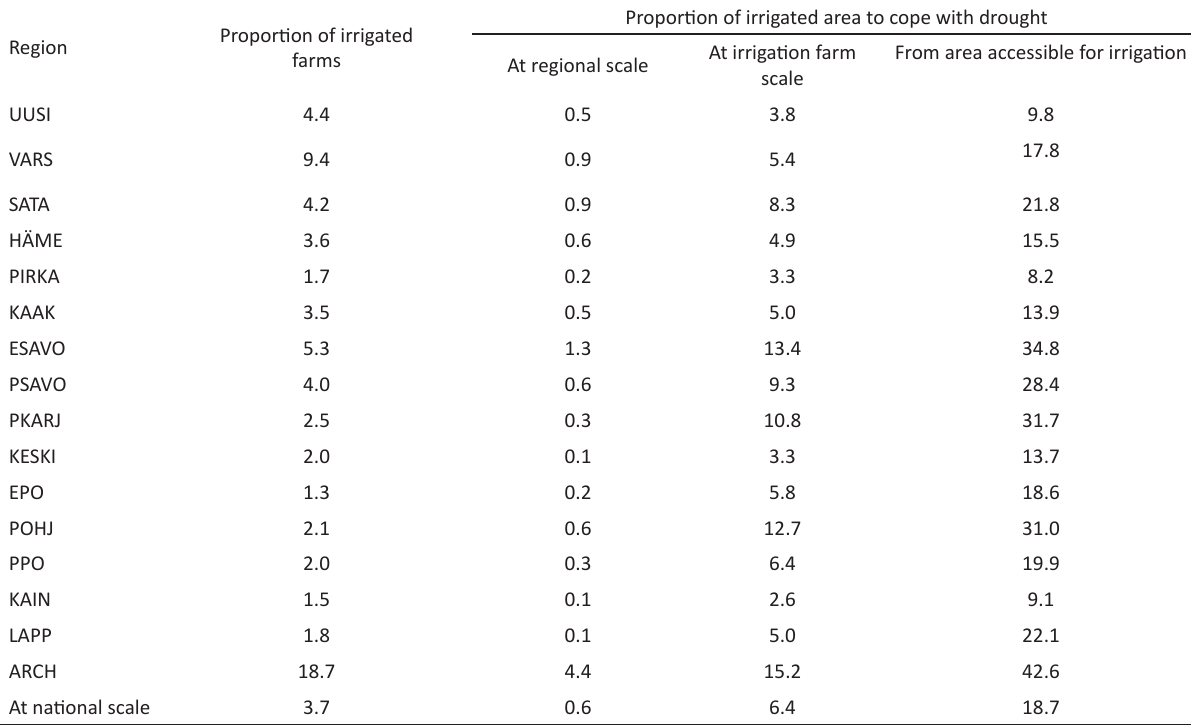
Table 4. Regional differences in proportion of irrigated farms (%) in 2010 and the proportion of area that was irrigated to cope with drought (%). See regions in Table 2 and Fig. 1. Data from Tike (2012). Proportion of irrigated area to cope with drought Proportion of irrigated Region At irrigation farm From area accessible for irrigation farms At regional scale scale UUSI 4.4 0.5 3.8 9.8 VARS 9.4 0.9 5.4 17.8